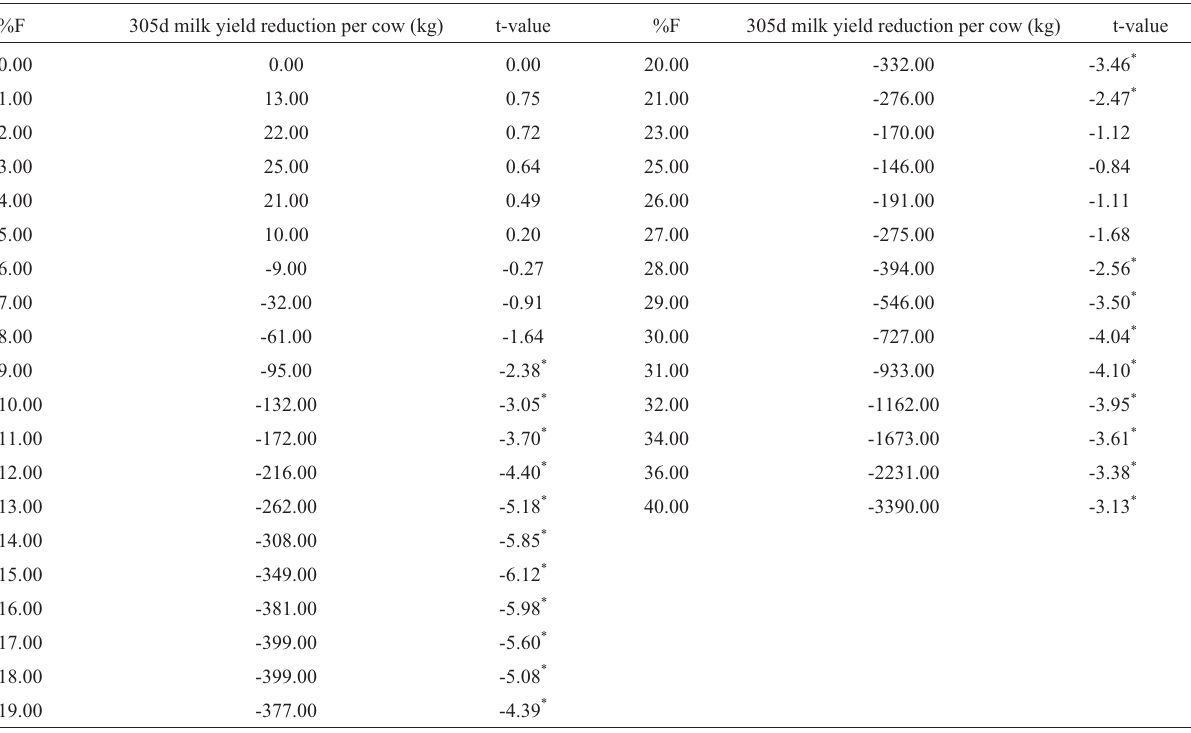
Table 4 - t statistics for testing significance in the reduction of 305 d milk yield (kg) between different inbreeding levels and 0% inbreeding from the cu- bic-spline interpolation model with seven